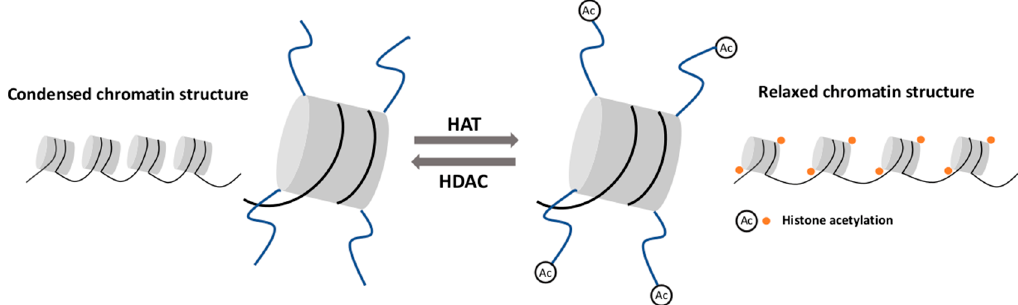
Figure 1. Histone acetylation and deacetylation. Histone acetyltransferase (HAT) attaches the acetyl group to the histone tail and leads to chromatin structure relaxation. Histone deacetylase (HDAC) removes the acetyl group and causes chromatin condensation.